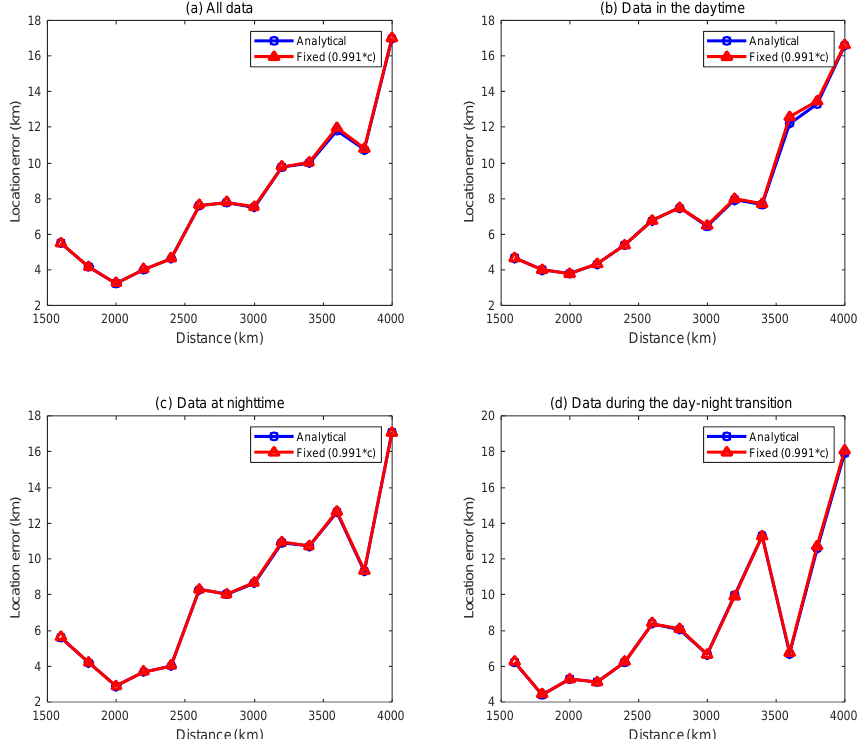
Figure 11. Comparison of localization error curves for fixed group velocity (0.991c) and the group velocity of the first-order mode: ( a ) all data; ( b ) data in the daytime; ( c ) data at nighttime; ( d ) data during the day – night transition.